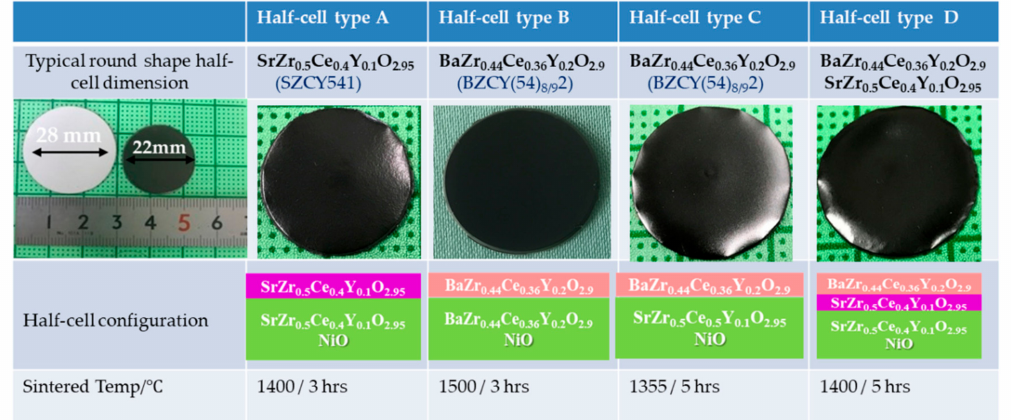
Figure 8. Photographic images of the as-fabricated round shape half-cell with di ff erent configurations (half-cell type A~D), typical dimension before and after sintering, and the sintering temperature.